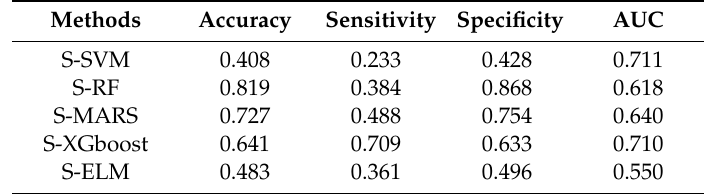
Table 3. Classification results of the five single methods.